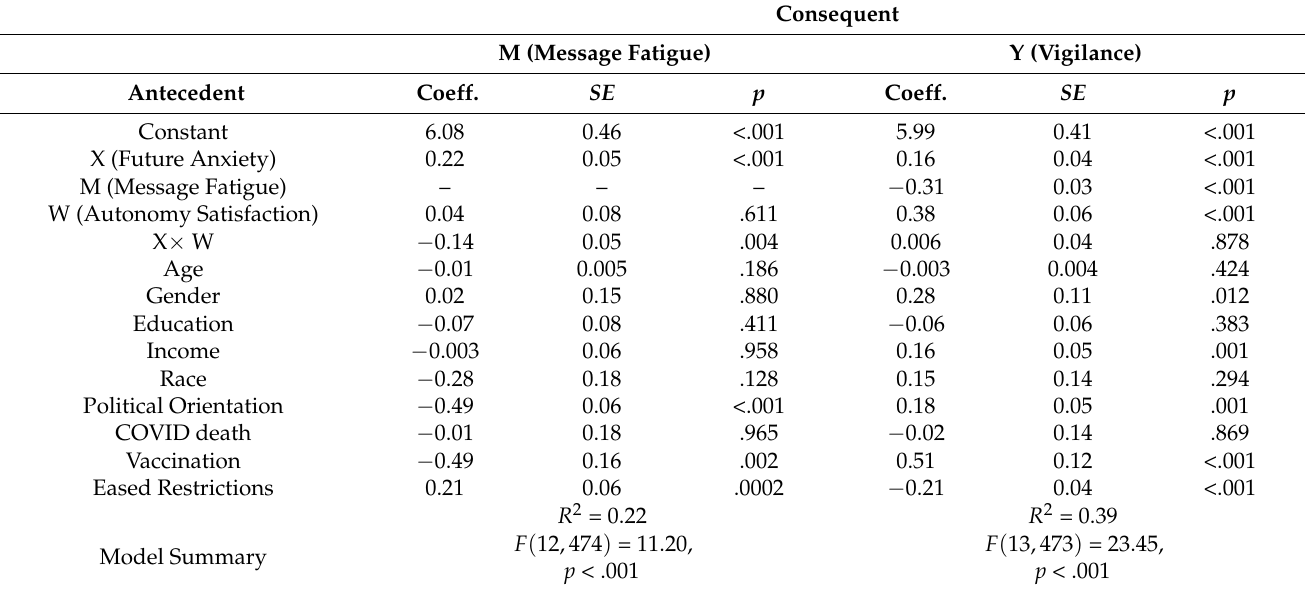
Table 1. OLS regression results based on PROCESS Model 8.